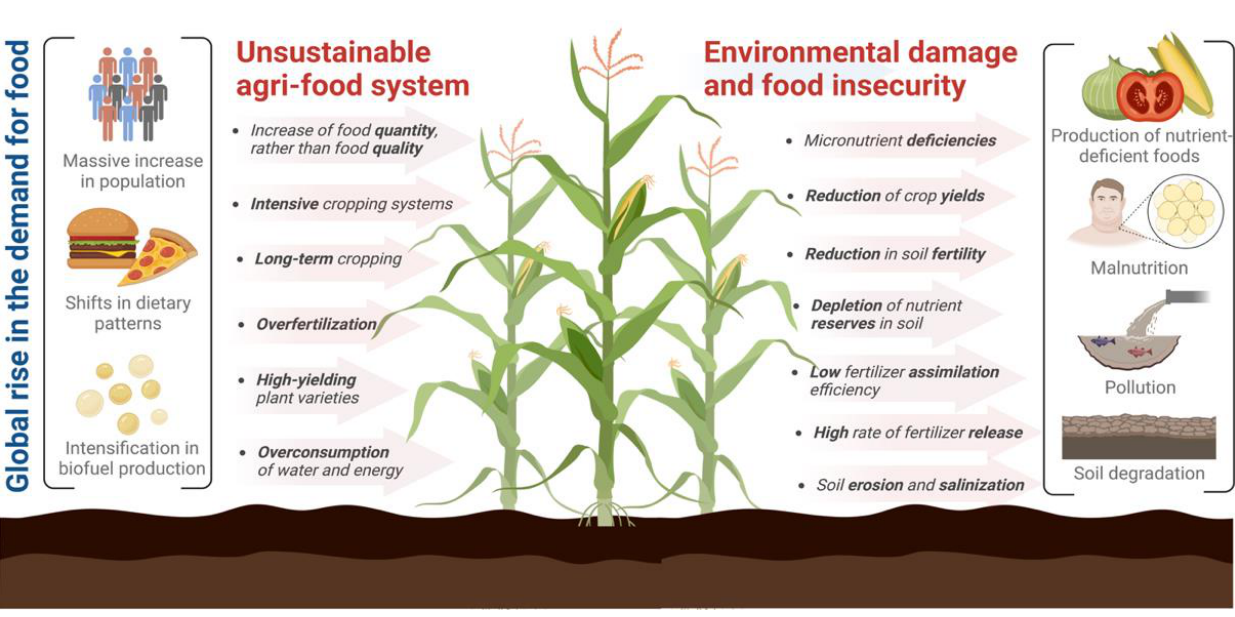
Figure 2. Unsustainable agri-food system contributing to food insecurity and environmental damage. Figure created with BioRender.com.